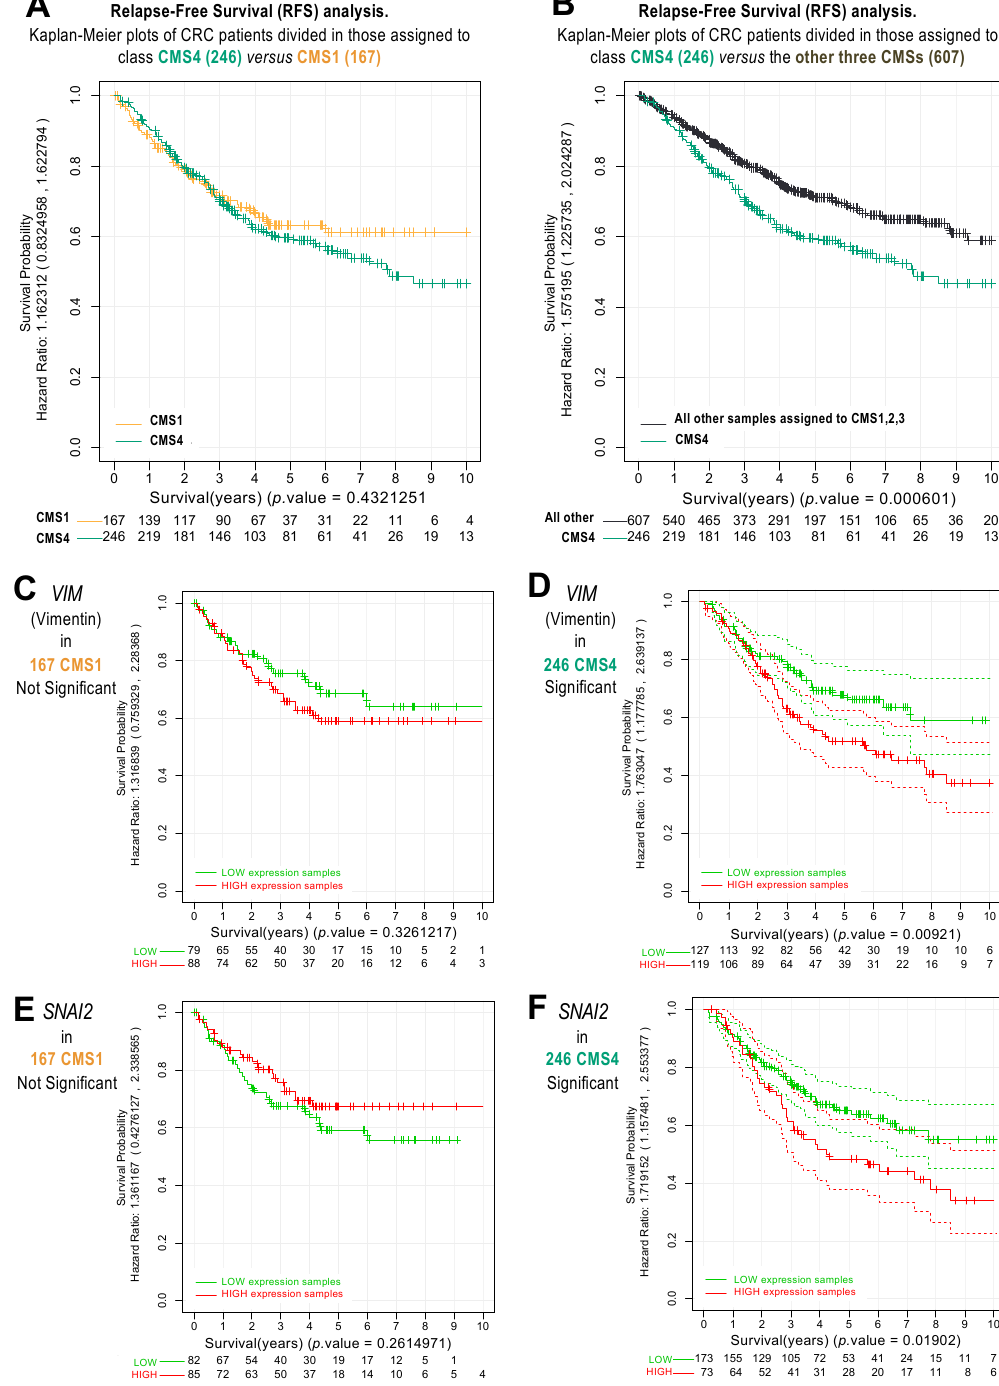
Figure 4. Kaplan–Meier survival analysis of CRC subtypes using the cohort of tumor samples presented in Figure 3. ( A ) Comparison of the relapse-free survival of the CRC samples identified as CMS4 (246) versus the CMS1 (167). ( B ) Comparison of the RFS of CMS4 (246) versus the ones assigned to all other CMSs (607 CMS1, 2, 3). ( C ) Comparison of the survival of 167 CMS1 samples, divided according to low or high expression of Vimentin. ( D ) Comparison of 246 CMS4 samples, divided by low or high expression of Vimentin. ( E ) Comparison of the survival of 167 CMS1 samples, divided according to high or low expression of SNAI2. (F) Comparison of 246 CMS4 samples, divided by high or low expression of SNAI2.